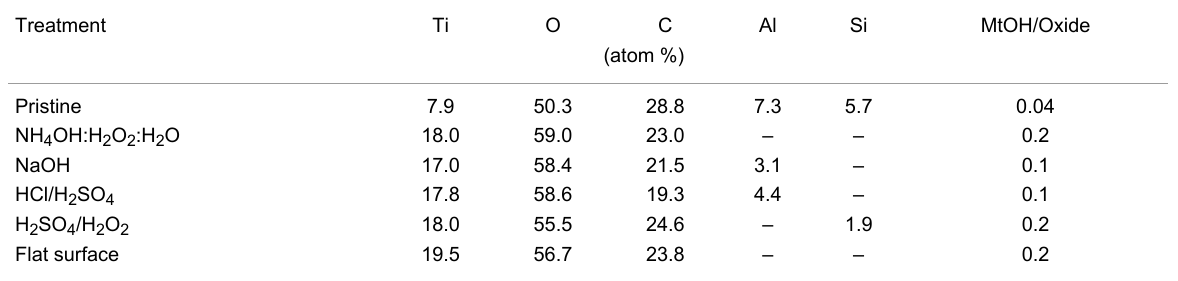
Table 1: Influence of the surface treatments on the surface concentration of elements present on pristine, activated and flat titanium surfaces, as determined by XPS. The ratio between the surface oxides and hydroxides determined from the analysis of the high resolution O 1s spectra is also